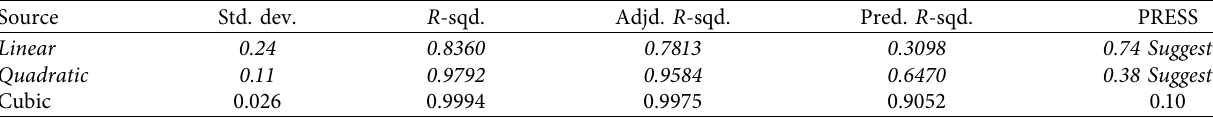
Table 12: Model summary statistics for flexural strength response.